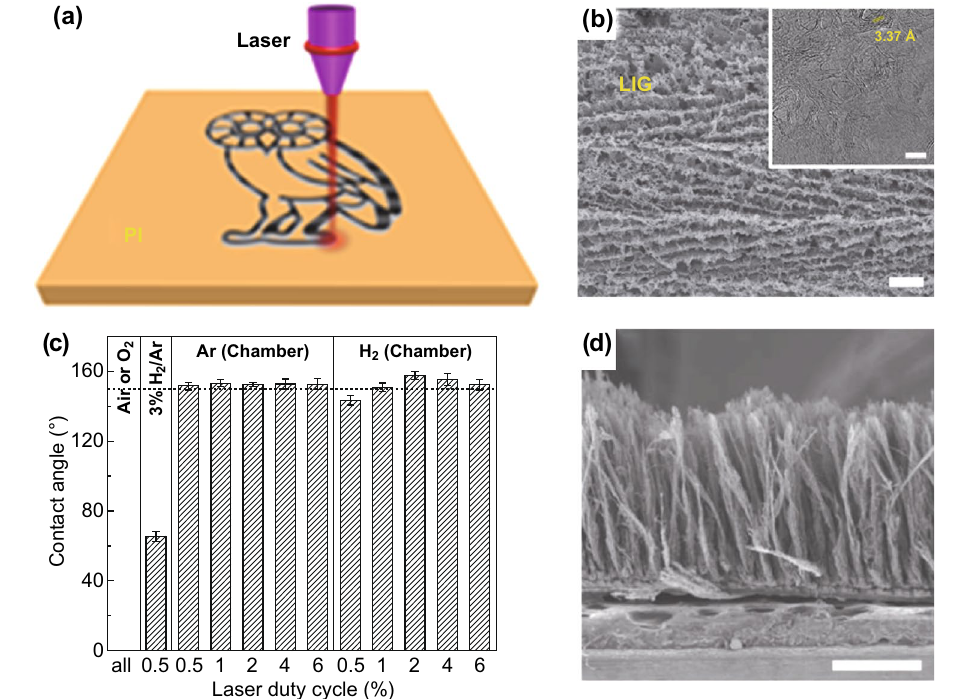
Fig. 1 Tunable structure and compositions of LIG. a Schematic of the synthesis process of LIG from PI. b SEM and HRTEM (inset) image of LIG, scale bar is 10 μm and 5 nm, respectively. a , b Adapted with the permission from Ref. [3], Copyright 2014 Springer Nature. c Contact angles of LIG samples prepared under different gas atmospheres with different laser duty cycles. Adapted with the permission from Ref. [41], Copyright 2017 WILEY-VCH Verlag GmbH & Co. KGaA, Weinheim. d SEM image of LIG fiber, scale bar is 500 μm. Adapted with the